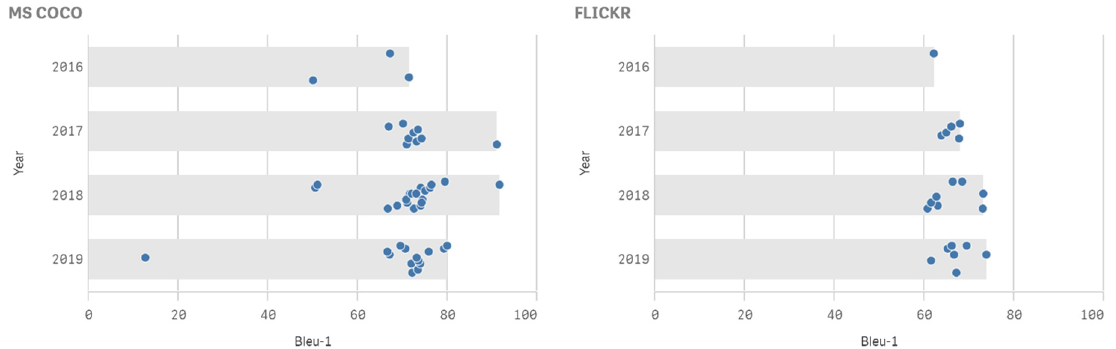
Figure 1. Bleu-1 results by year on MSCOCO ( left ) and Flickr30k ( right ).